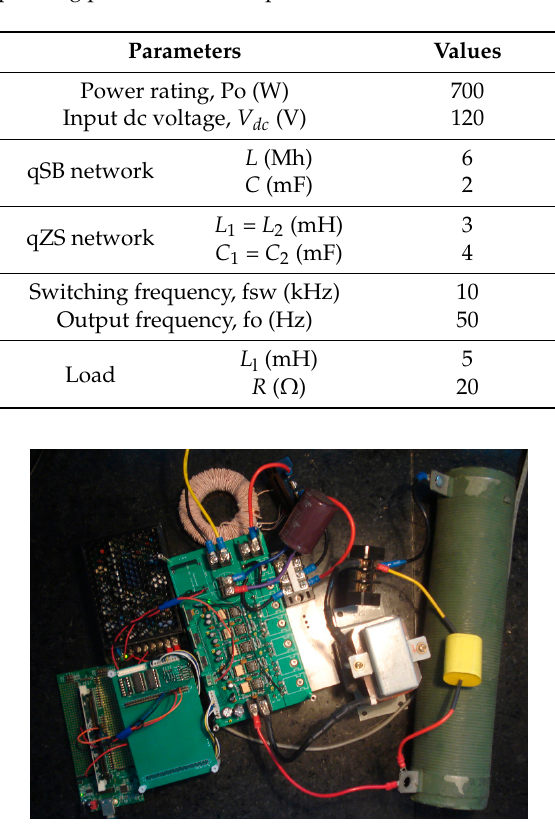
Table 1. Operating parameters for improved SBI and QZSI in the experiment.